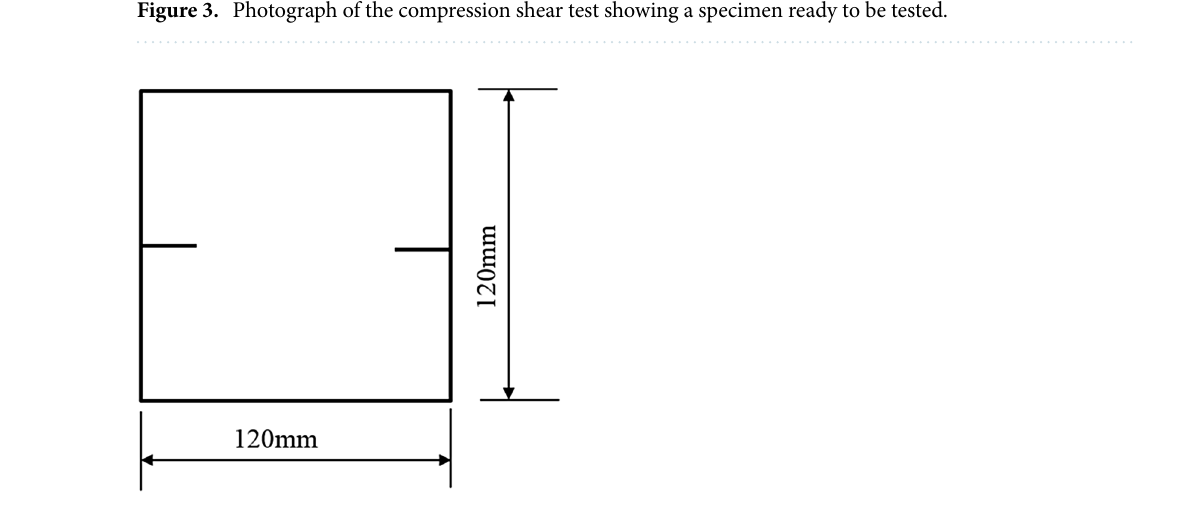
Figure 4. Precast crack orientation 1. Fissure length 2